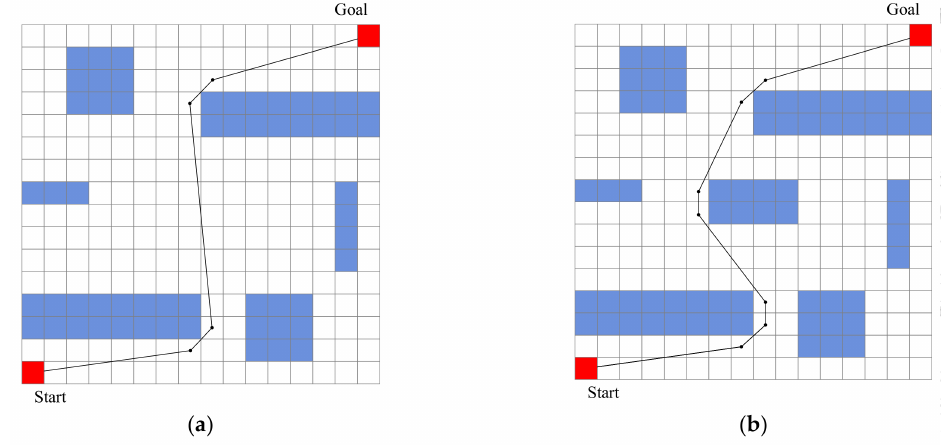
Figure A1. Dynamic environment scenario. ( a ) Origin Environment 1; ( b ) changed Environment 1.